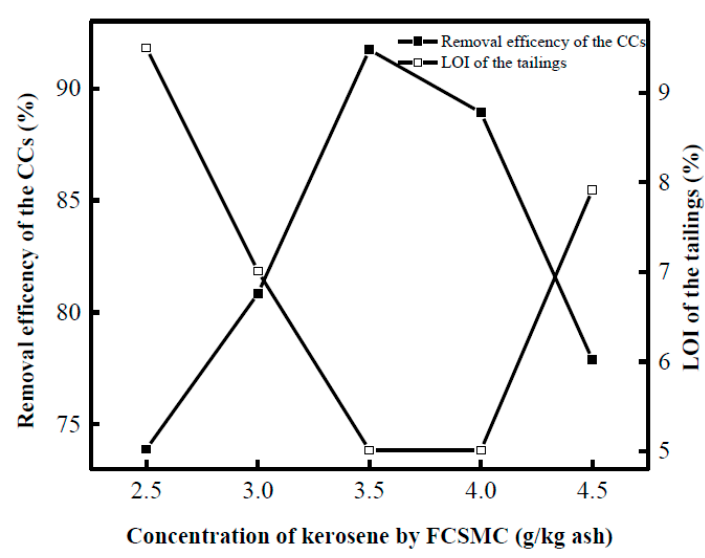
Figure 2. Effect of kerosene concentration on decarburization by FCSMC: methyl isobutyl carbinol (MIBC) = 0.2 g/kg·ash, Tween 80 = 7.5% of kerosene concentration, slurry concentration = 100 g/L, and pump speed = 380 r/min.